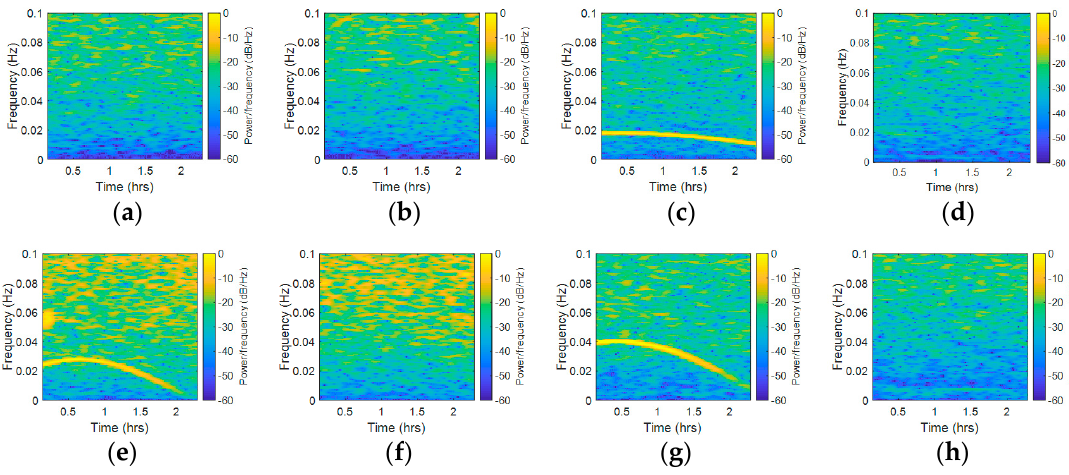
Figure 12. STFT results of Site A and Site C (baseline 69.79 m), ( a ) Site A, C01, ( b ) Site C, C01, ( c ) Site A, C06, ( d ) Site C, C06, ( e ) Site A, R05, ( f ) Site C, R05, ( g ) Site A, G02, ( h ) Site C, G02.